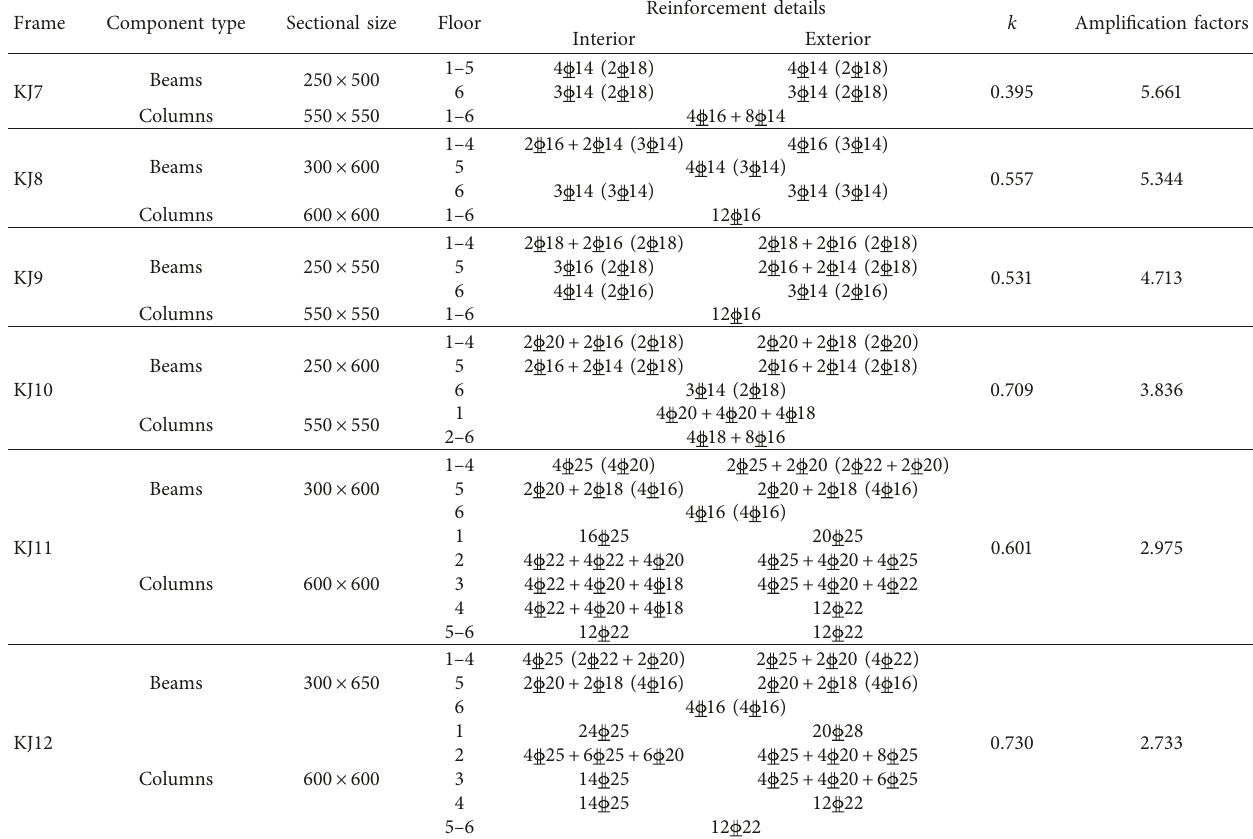
Table 18: Design parameters of numerical examples (considering the limit values in Table 2).